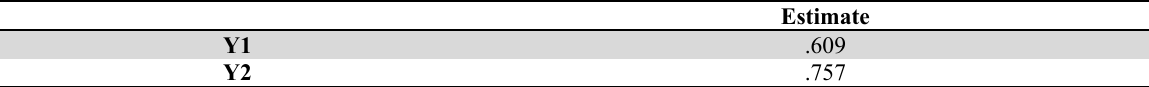
Squared Multiple Correlations